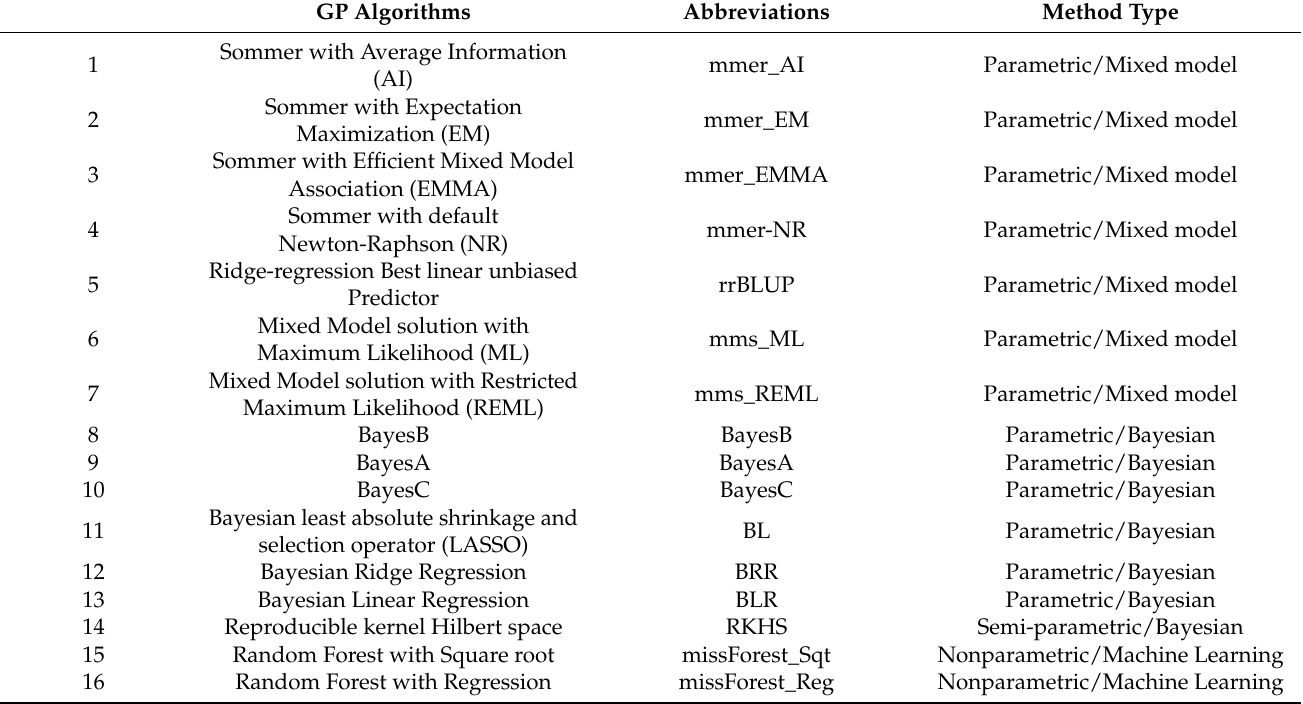
Table 3. Genomic prediction methods used for the analysis of the different traits and